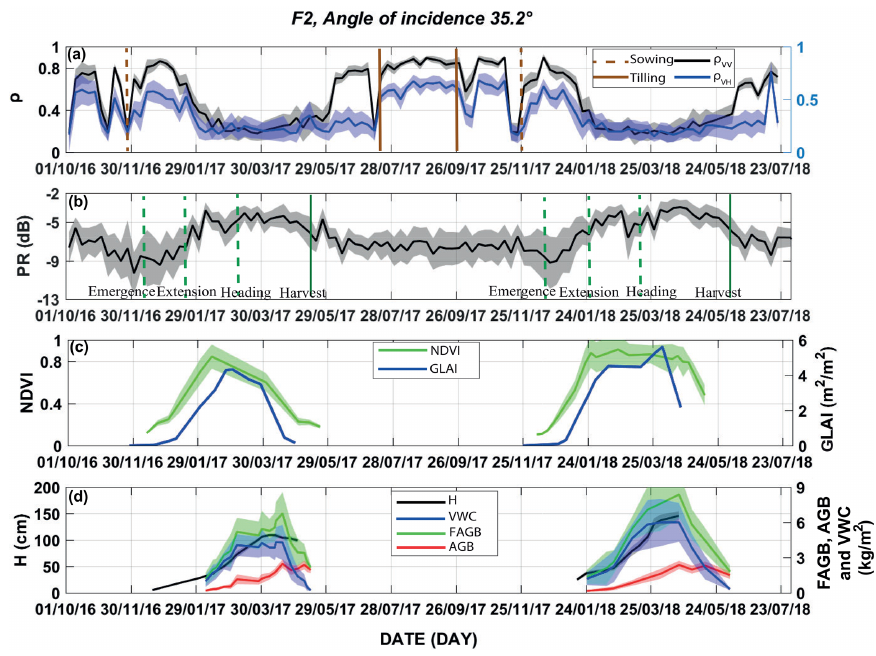
Figure A8. Time series of the interferometric coherence at VV and VH polarizations (a) and the polarization ratio (b) on F2 at a 35.2 ◦ incidence angle during the period from 1 October 2016 to 31 July 2018. The tilling works and phenological stages of wheat are superimposed in panels (a) and (b) , respectively. The NDVI and measured GLAI are displayed in panel (c) . Measured H , FAGB, VWC and AGB are plotted in panel (d) . Time series are presented by mean values (solid lines) and standard deviations (shading surrounding the solid